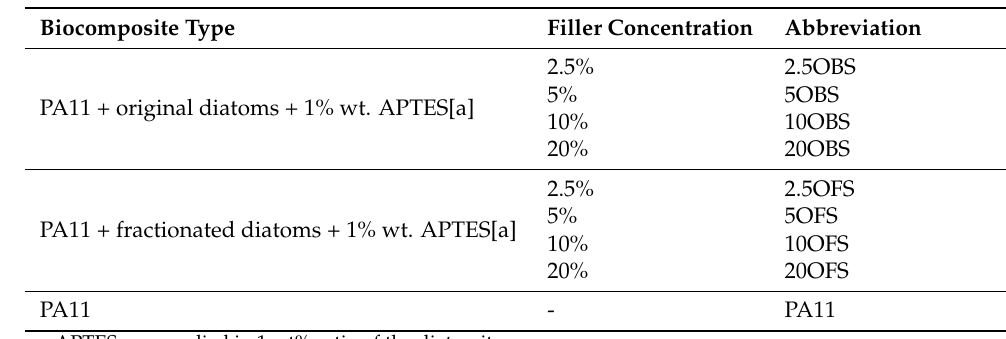
Table 3. Composites obtained for